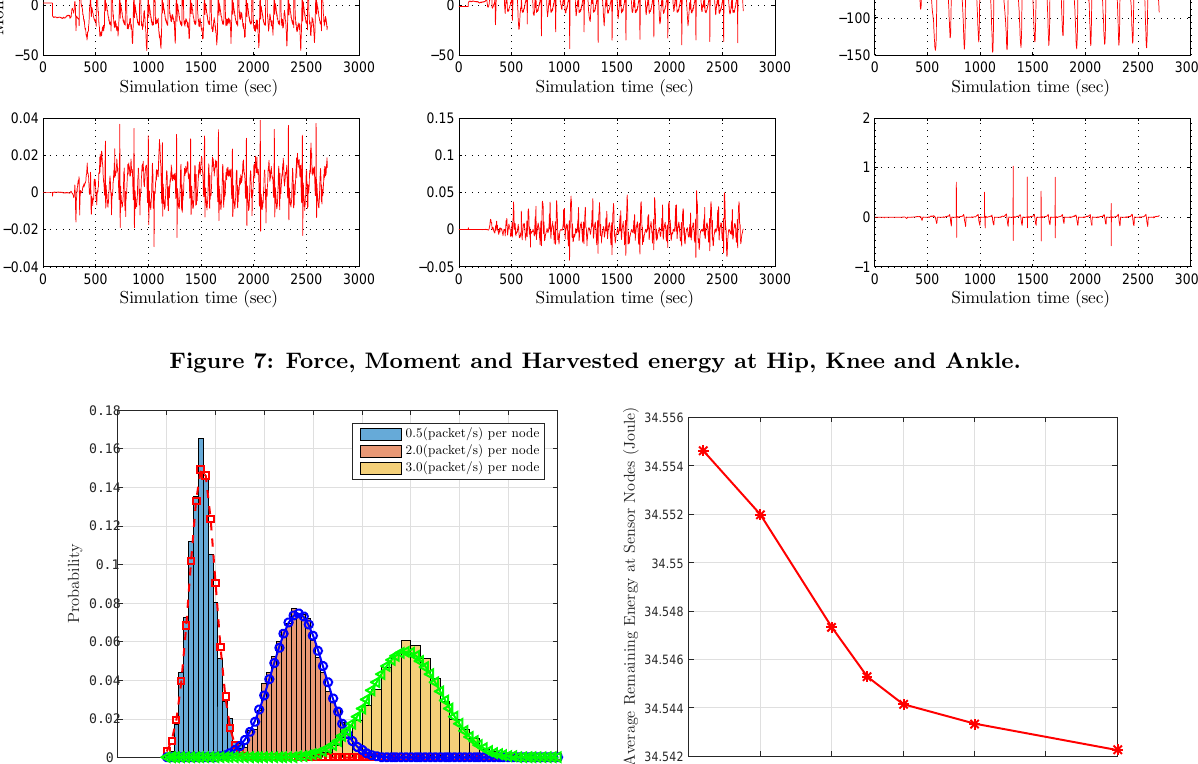
-10 Total incoming packet (packet) Figure 8: Incoming traffic at the CCU & Relationship of the Remaining Energy and Incoming